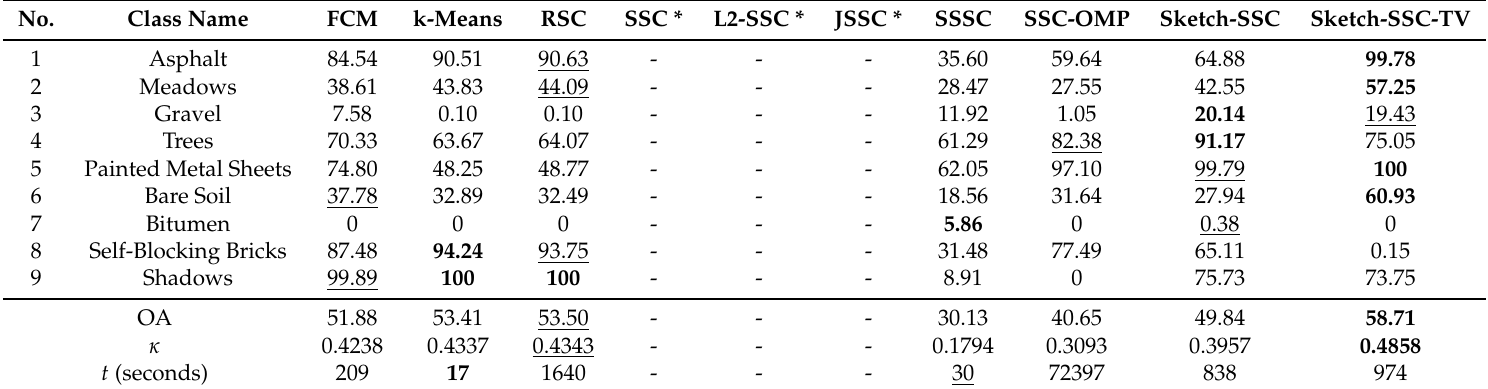
Table 4. Clustering accuracy for Pavia University